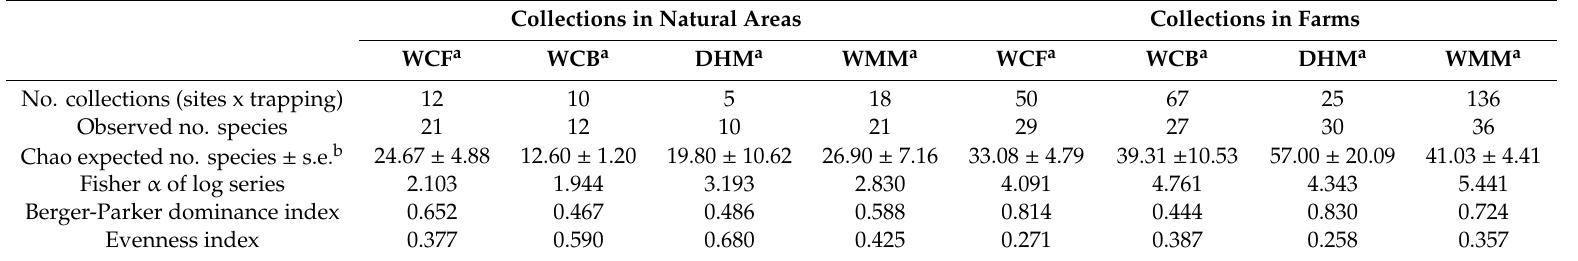
Table 5. Description of the Culicoides species communities (observed and extrapolated species richness, alpha of log series, the Berger–Parker dominance, and the evenness indices) collected in natural zones (June to August 2008) and in farms (2009–2012) using UV-light suction traps (OVI model) in five di ff erent ecological and climatic French regions.